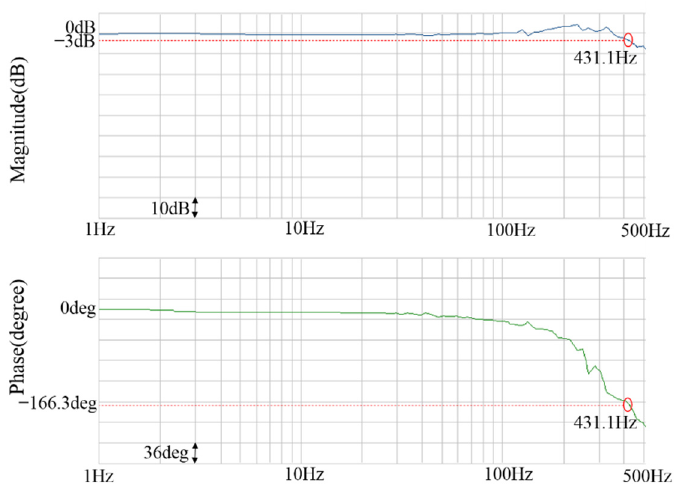
Figure 19. Bode plots of q -axis current control loop using PID neural network controller at 2000 rpm